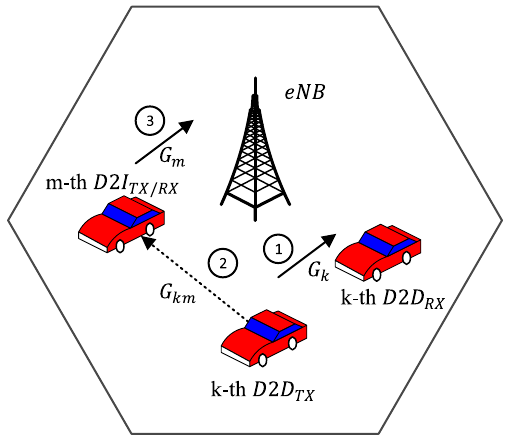
Fig. 1 A typical network is consisting of one eNB, one D2D‑UE, and one D2I‑UE. The k − th D2D